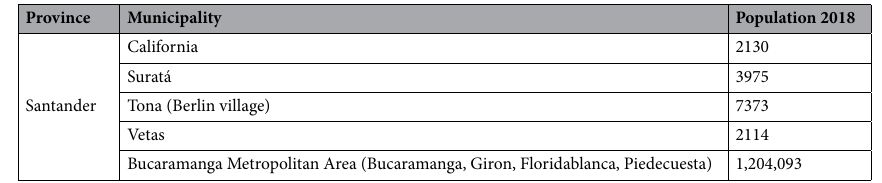
Table 1. Number of inhabitants by municipality.